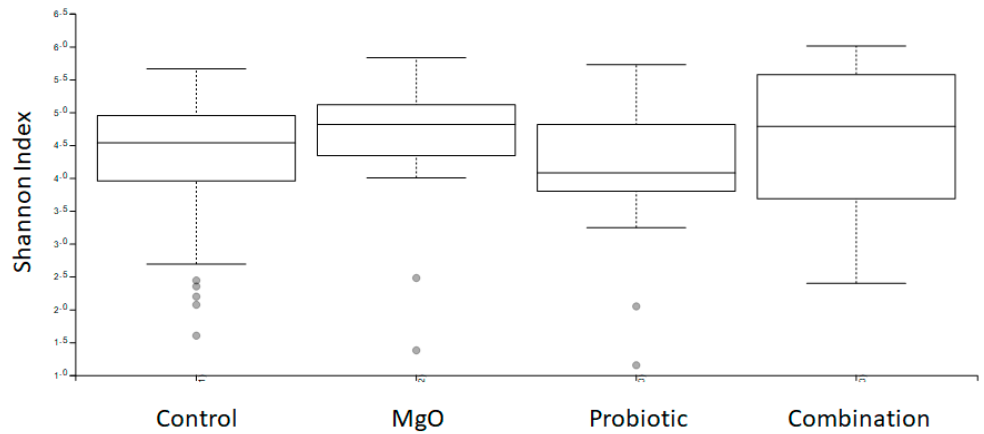
Figure 3. Administration of the probiotic L. reuteri , magnesium oxide, or both does not change the distribution of the gut microbiome. Feces were obtained from the patients before and after the treatment. The distribution of alpha diversity within groups was measured by the Shannon index. No marked differences were observed among the groups.